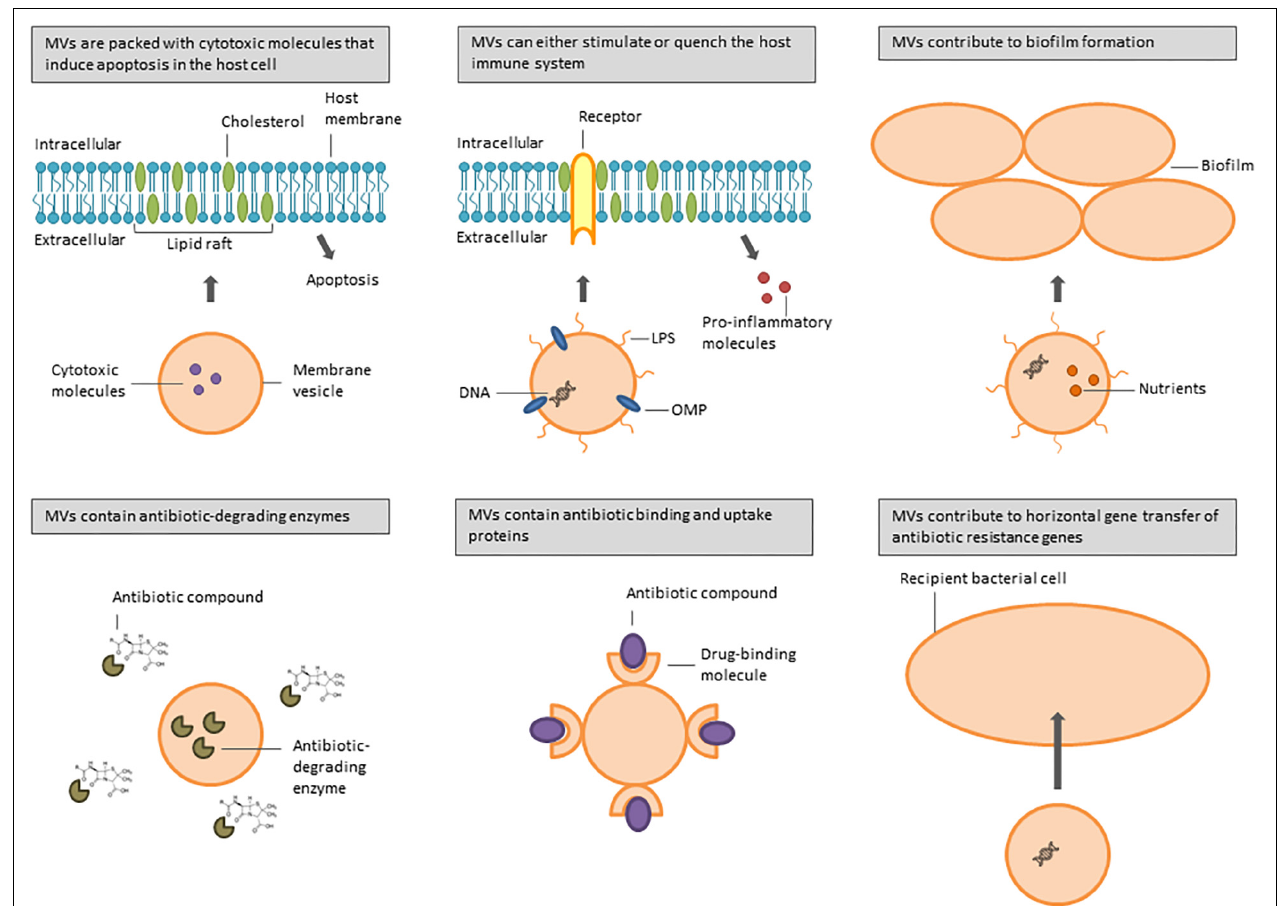
FIGURE 1 | Overview of functions of MVs secreted by bacteria involved in CF and nosocomial lung